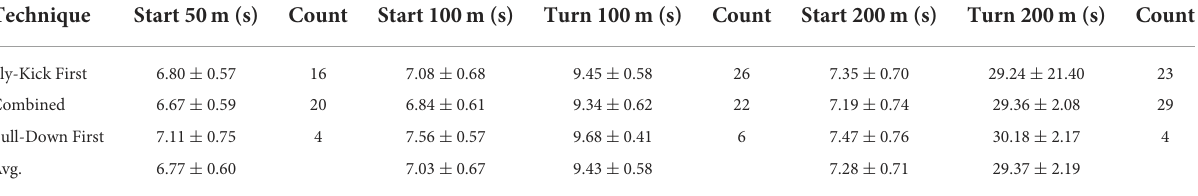
TABLE 1 Descriptive statistics for start and turn performances for each of the underwater pullout techniques across the 50, 100, and 200m breaststroke race events.